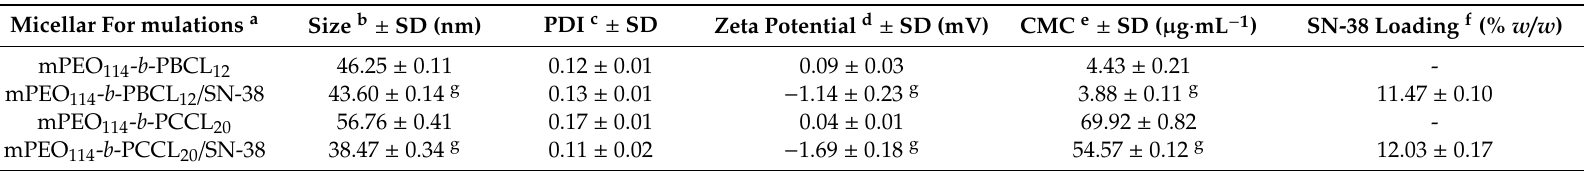
Table 1. Physicochemical characteristics of the self-assembled block copolymers and SN-38-conjugated block copolymer micelles ( n = 4). Micellar For mulations